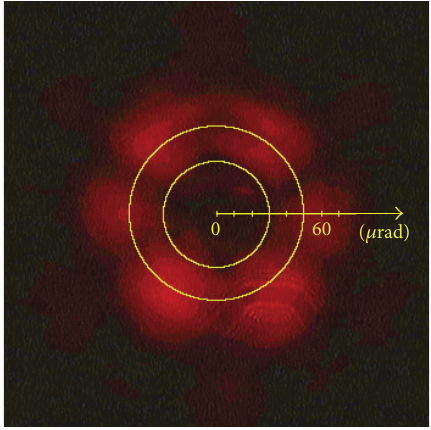
Figure 8: FFDP, in air, of CCR n.51 at room temperature. The dihedral angles offset from 90 ∘ are for this CCR 1.14, 1.43, and 1.55 arcseconds.